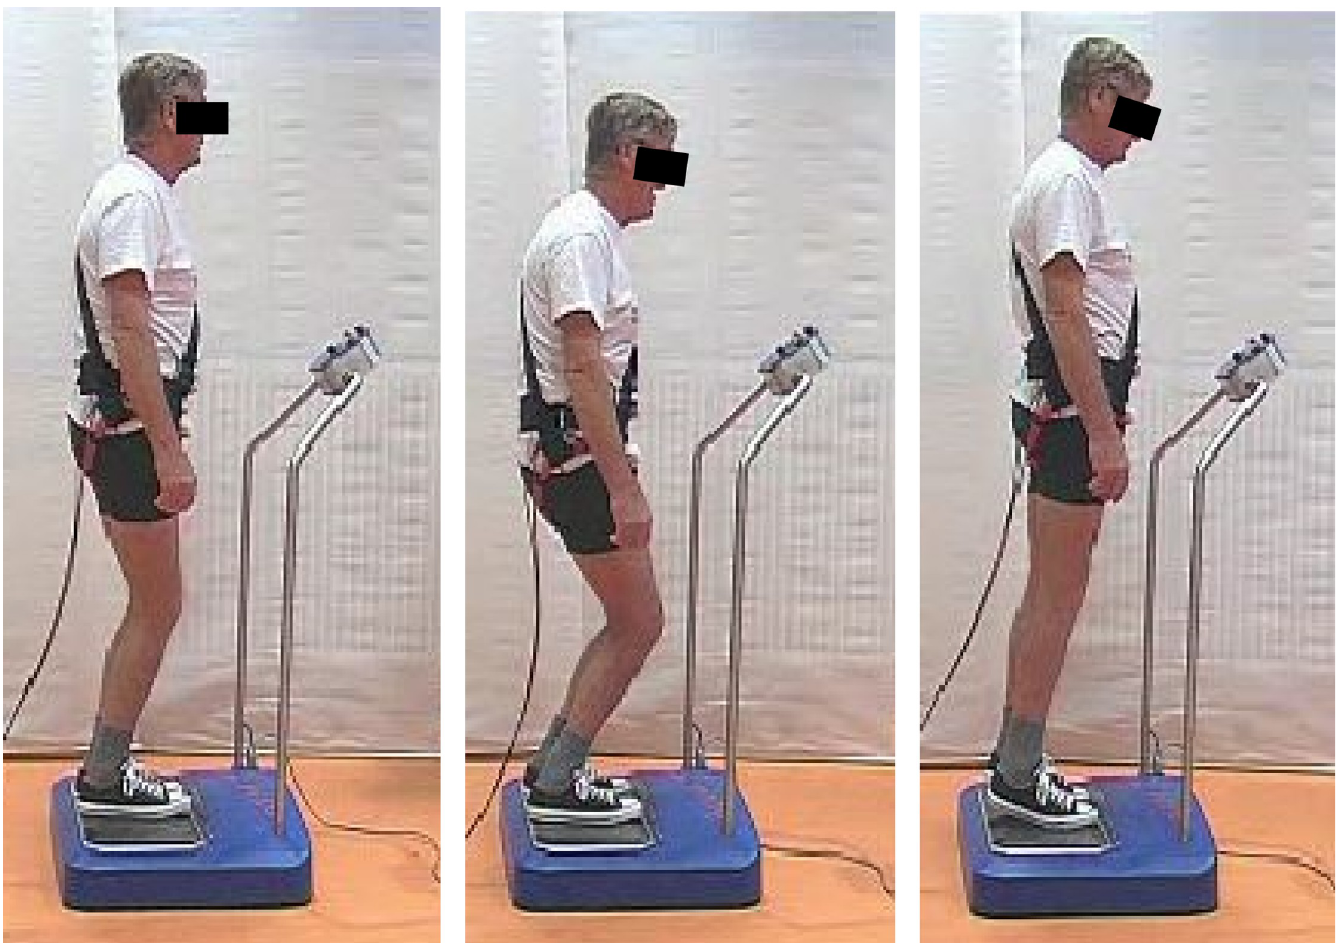
Fig 1. Subject in three positions on Powerplate. From left: Knees 15˚ flexed, knees 50˚ flexed, forefoot stance.